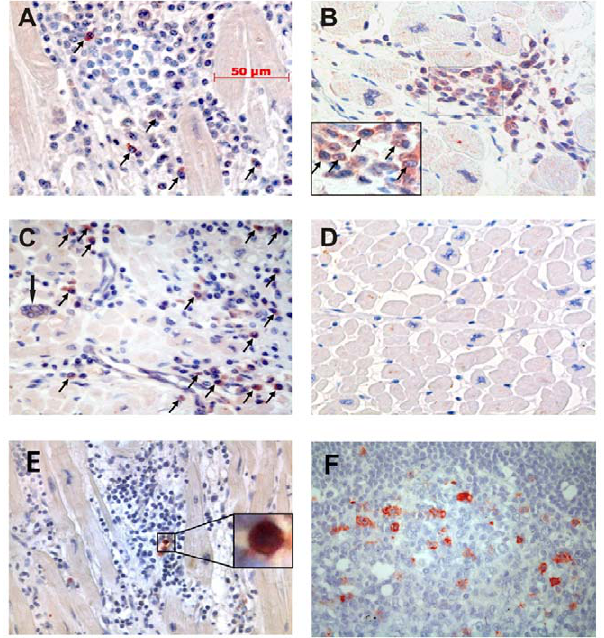
Figure 7. CTLA-4 and CD57 expression in the heart of chronic Chagas disease patients with severe cardiomyopathy. CTLA-4 and CD57 expression was assessed by immunohistochemistry in explanted heart tissue sections from chronic Chagas disease recipients. Two representative staining where CTLA-4 expression (arrows) was detected. Original magnification, 400 6 (A and B inset magnification, 1000 6 ). Giant cell myocarditis infiltrate showing a typical giant cell (arrowhead), severe diffuse infı´ltrate and CTLA-4 expression (arrows). Original magnification 400 6 (C). No CTLA4 + cells were observed in idiopathic dilated cardiomyopathy heart tissues. Original magnification, 400 6 (D). CD57 expression in heart tissues from a T. cruzi -infected subject (E) and in lymph node tissues (F). Original magnification, 400 6 .